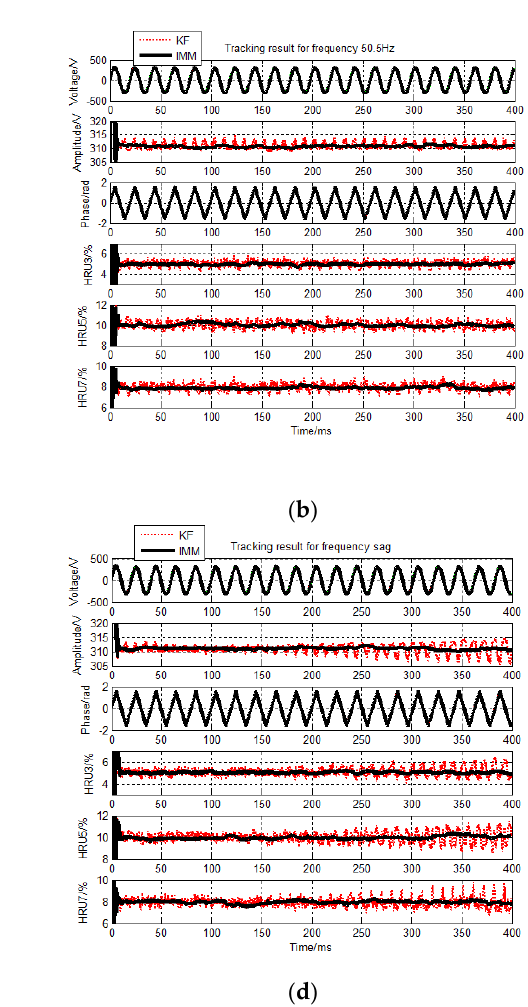
Figure 7. Simulation tracking results for voltage frequency heavy fluctuations. ( a ) Simulation tracking results for frequency 49.5 Hz; ( b ) Simulation tracking results for frequency 50.5 Hz; ( c ) Simulation tracking results for frequency swell; ( d ) Simulation tracking results for frequency sag.